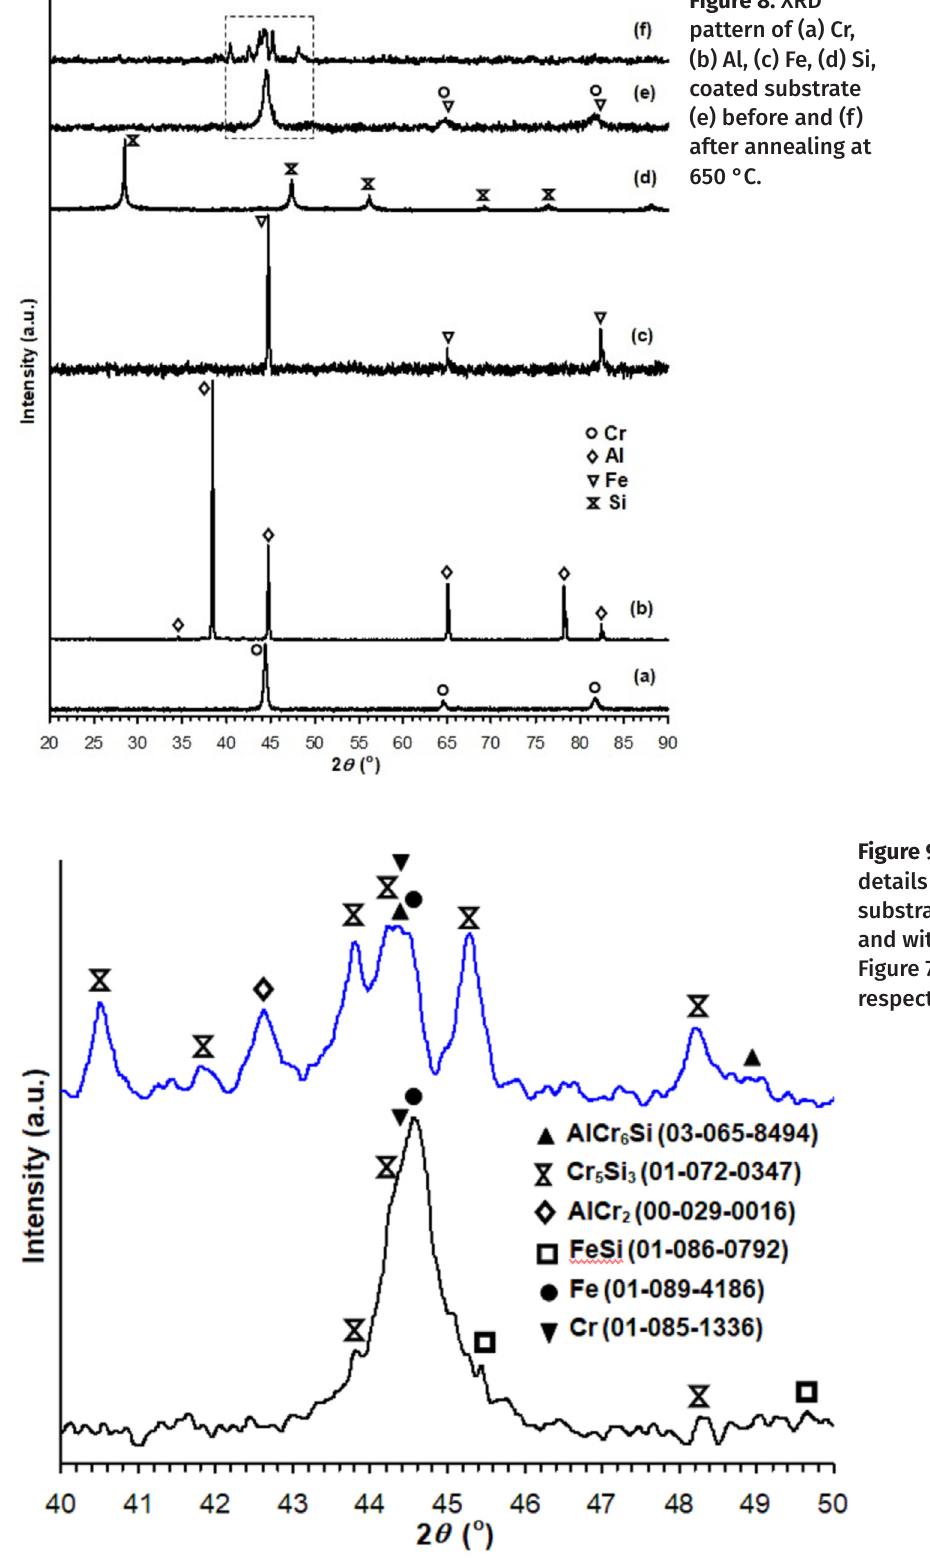
Figure 8. XRD pattern of (a) Cr, (b) Al, (c) Fe, (d) Si, coated substrate (e) before and (f) after annealing at 650 °C.